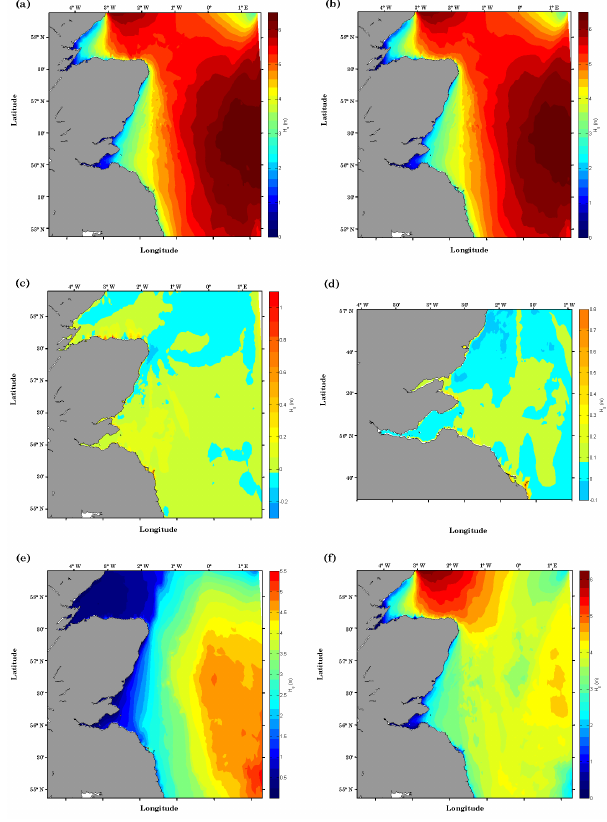
Figure 19. The modelled H s on the east coast of Scotland at 19:00UTC on 19 June 2010: (a) coupled model (mean WCI in- cluded), (b) uncoupled model (mean WCI not included), (c) dif- ference between coupled and uncoupled models, (d) difference be- tween coupled and uncoupled models in the Firth of Forth area, (e) windsea waves, (f) swell waves.